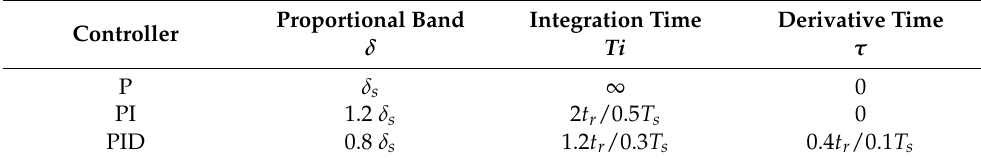
Table 2. PID regulator parameter tuning based on the attenuation curve method.